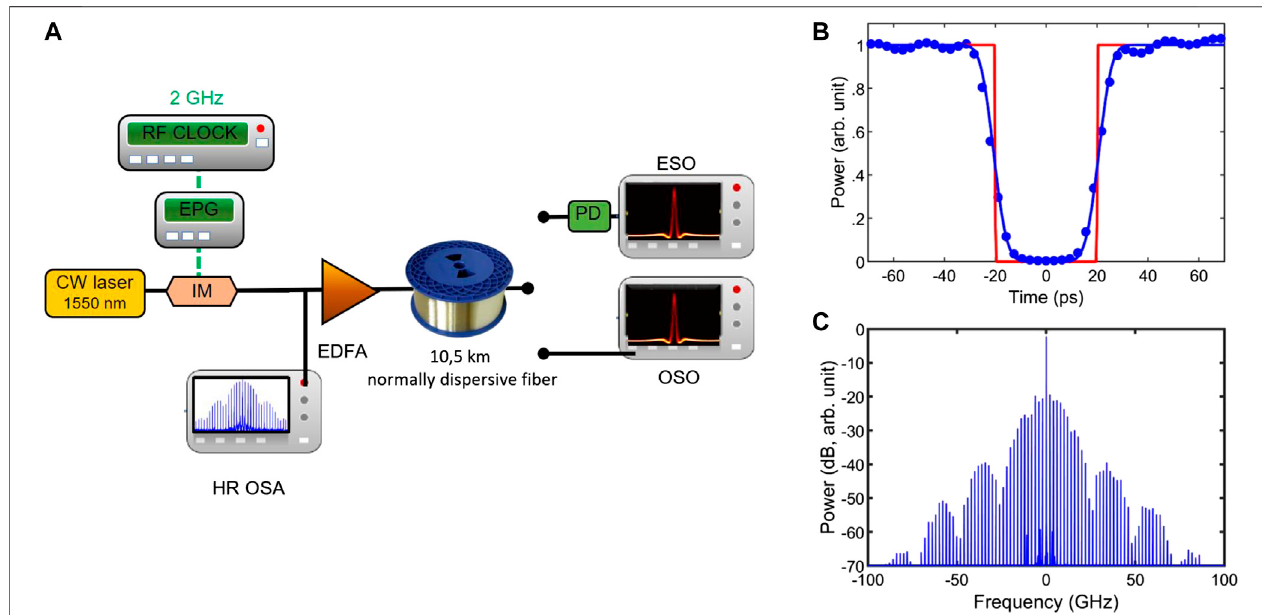
FIGURE 1 | (A) Experimental setup: CW: continuous wave; IM: intensity modulator; EDFA: erbium-doped fi ber ampli fi er; OSO: optical sampling oscilloscope; PD: photodiode; ESO: electrical sampling oscilloscope; HR OSA: high-resolution optical spectrum analyzer. (B) Temporal intensity pro fi le of the input pulse. Experimental results (circles) are fi tted with an inverted super-Gaussian pulse (blue solid line) and compared with an ideal rectangular waveform (red). (C) Experimental optical spectrum of the input